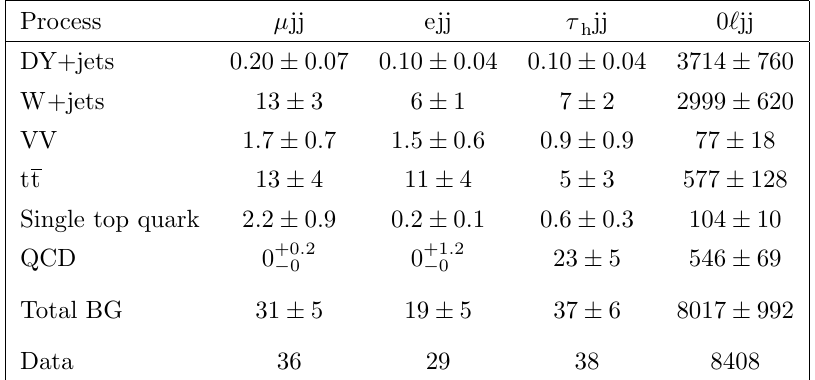
Table 1 . The number of observed events and corresponding pre-(cid:12)t background predictions, where \pre-(cid:12)t" refers to the predictions determined as described in the text, before constraints from the (cid:12)tting procedure have been applied. The uncertainties include the statistical and systematic